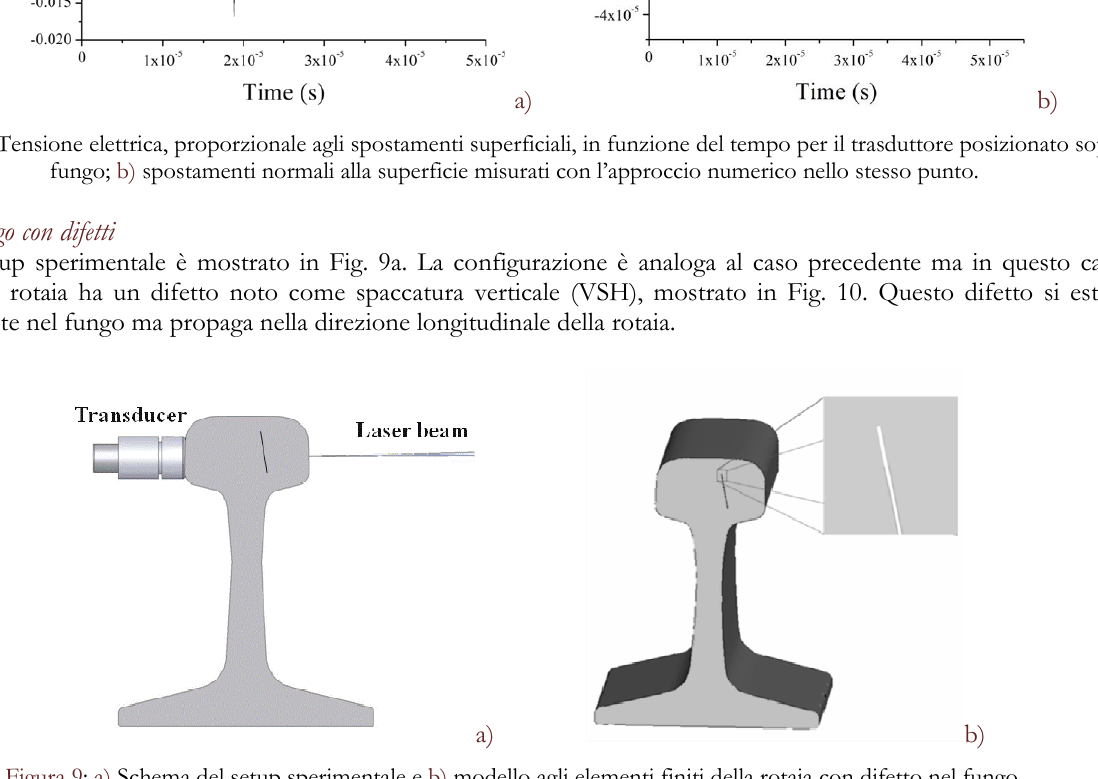
Figura 9: a) Schema del setup sperimentale e b) modello agli elementi finiti della rotaia con difetto nel